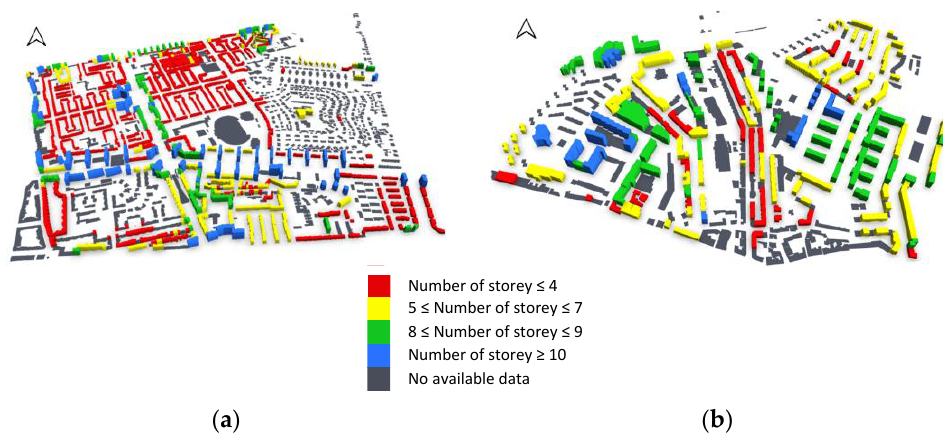
Figure 12. Number of storeys thematic map of ( a ) Alvalade and ( b ) Benfica.